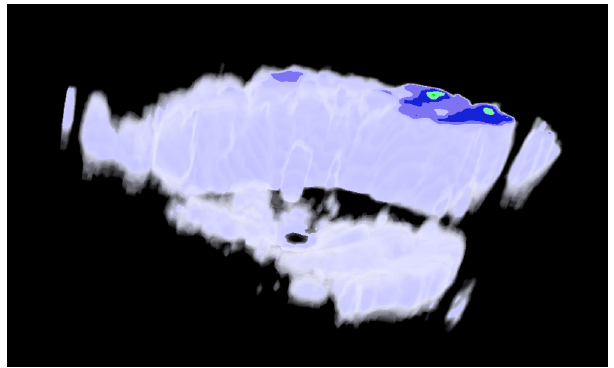
Figure 11. Visualization of radar volumetric scanning data.